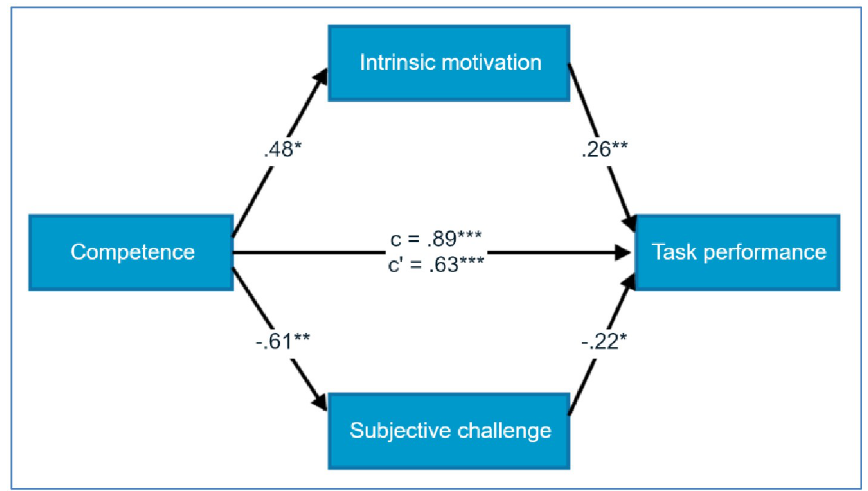
Fig 1. Standardised regression coefficients for the mediational effects of intrinsic motivation and subjective challenge in the relationship of competence and task performance level in Study 1.